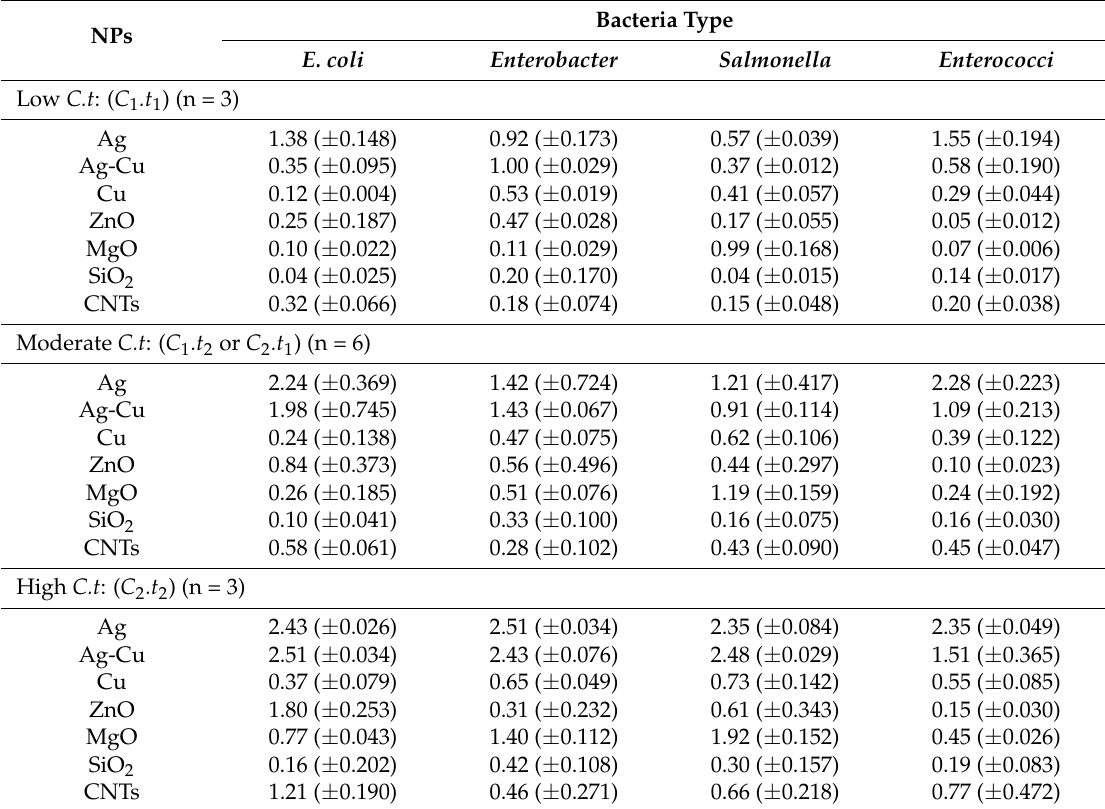
Table 7. Average log inactivation of spiked MSF water treated by NPs a .